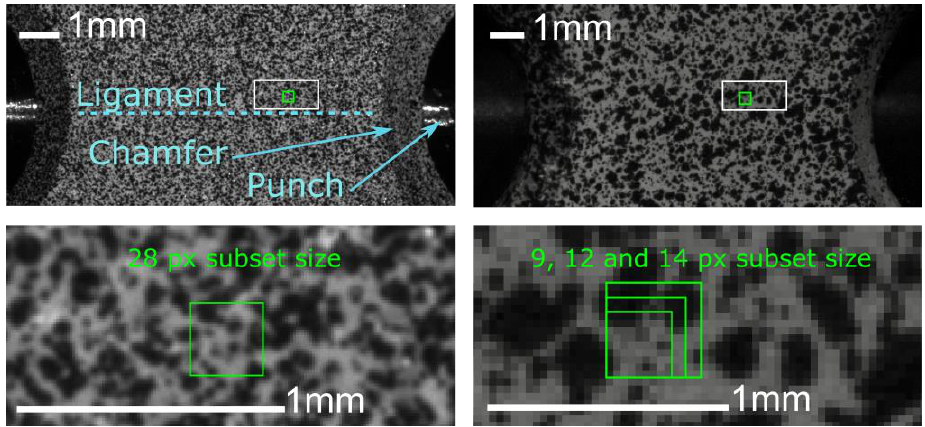
Fig. 3 . Comparison of recorded images from quasi-static (left) and high strain rate set-ups (right). Original images are plotted on top, the ligament is indicated with a dashed light blue line. The respective close up views (white boxes) are presented on the bottom, along with the subset size (green lines).